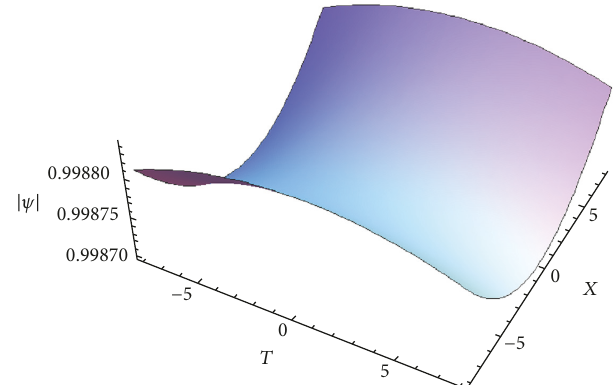
Figure 9: Spatial structure of the module of solution (81) with 𝑘 = 0.05 .